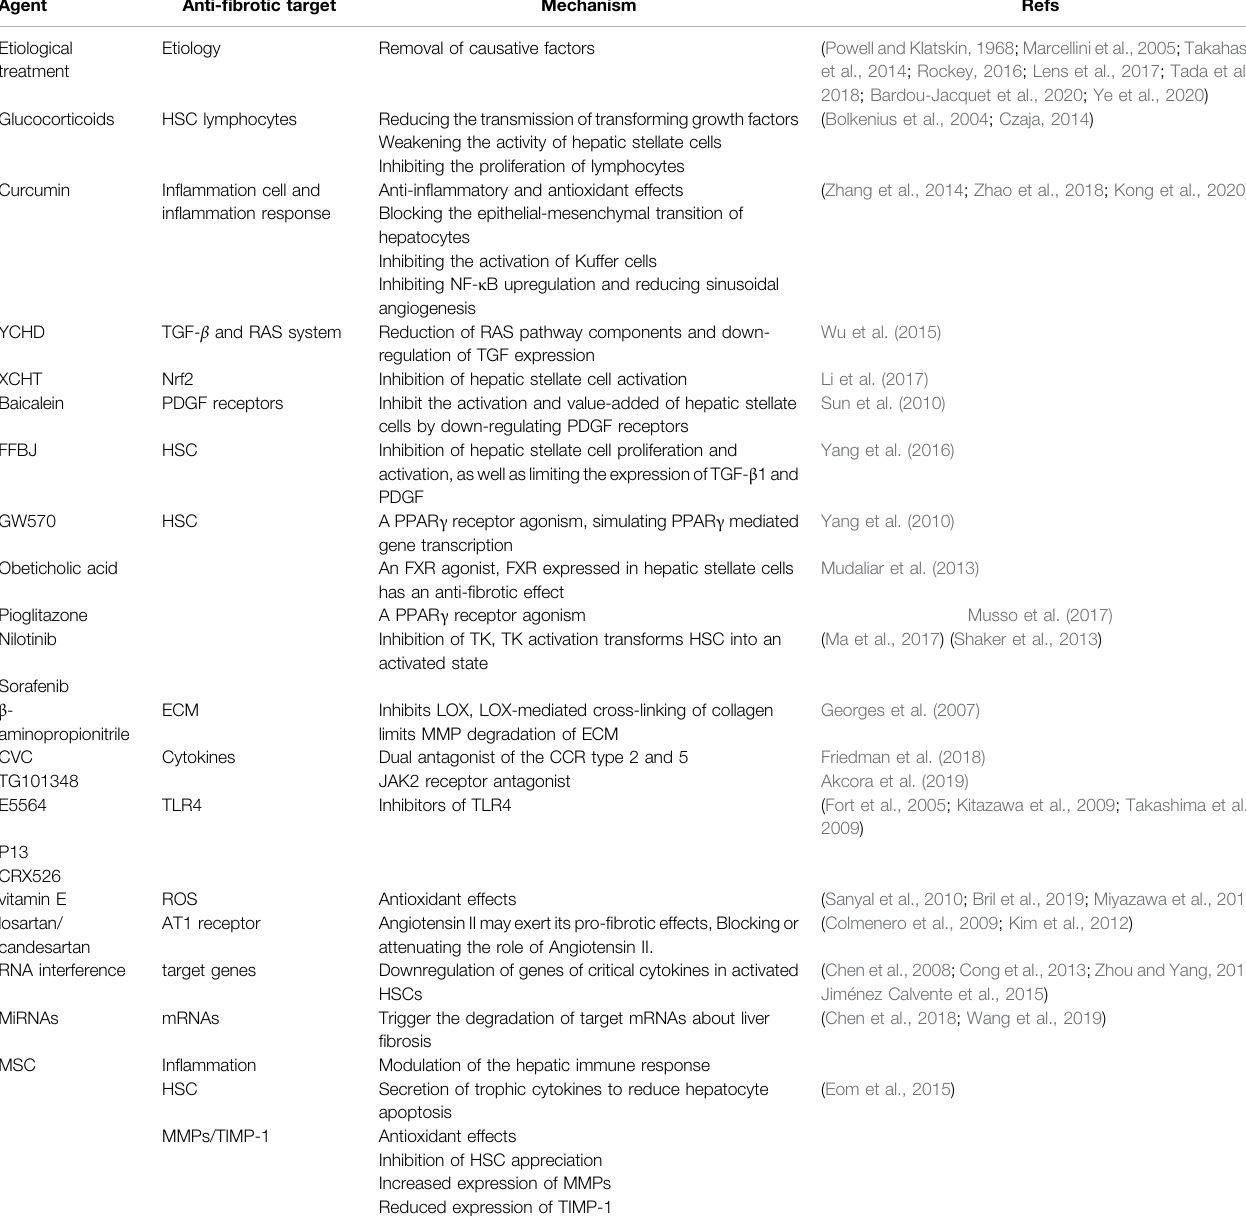
TABLE 1 | Targets and main mechanisms of some of existing anti- fi brotic drugs and novel therapeutic